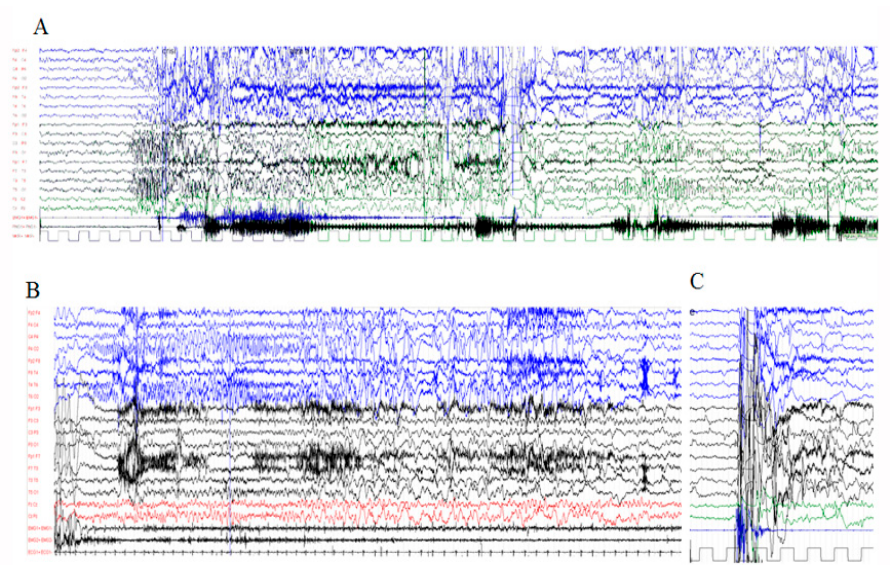
Figure 1. Group1: Ictal EEG in a 6-year-old boy (Pt5, Lys601Gln). ( A ) Left hyperkinetic seizure: Ictal discharge characterized by rapid spikes, starting on the left middle and posterior areas and spreading to the same right regions, followed by diffuse slow waves. After 10 s, a discharge of rapid SW started on the left occipital regions, lasting 20 s. ( B ) Right focal seizure characterized by sustained right deviation of the eyes and head, followed by eye clonic movements. Ictal discharge, starting in the right posterior regions, characterized by rapid spikes, then by SW and then again by rapid spikes. ( C ) Muscle artifacts associated with a startle response without paroxysmal abnormalities.